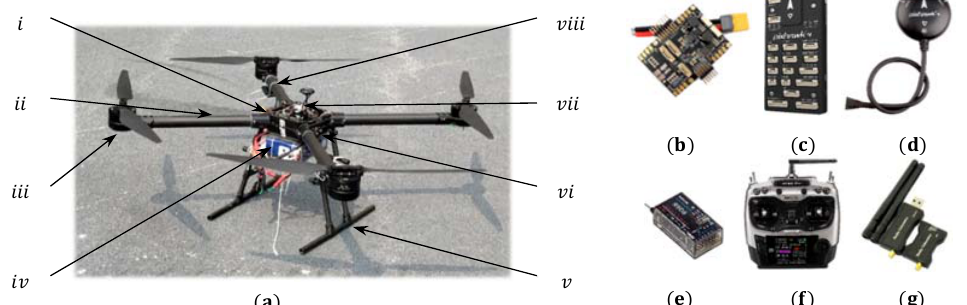
Figure 7. Quadrotor hardware and flight controller; ( a ) quadrotor frame: (i) electronics box, (ii) arm, (iii) rotor, (iv) battery, (v) landing gear, (vi) body frame, (vii) flight controller, and (viii) height sensor; ( b ) power module; ( c ) motherboard unit; ( d ) GPS; ( e ) radio receiver; ( f ) radio controller; and ( g ) RX ‐ TX ground control ‐ station connector.